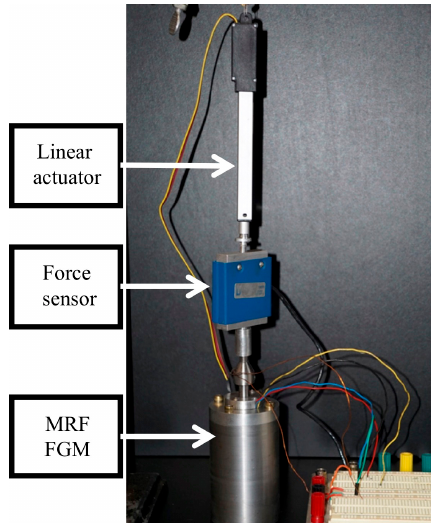
Figure 4. Schematic architecture of the experimental setup.